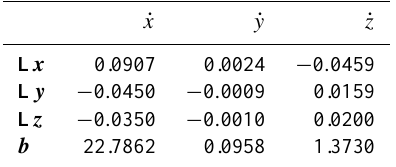
Fig. 2. Anomaly correlation calculated for the two imperfect models and the models obtained by the two model correction techniques. Table 2. The estimated coefficients of Leith’s operator (12) and the bias term